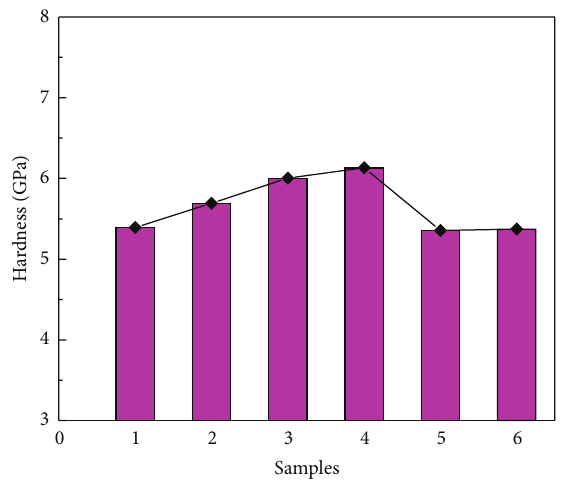
Figure 6: Vickers’ hardness changes for different locations showing hardness marks for location #1 ∼